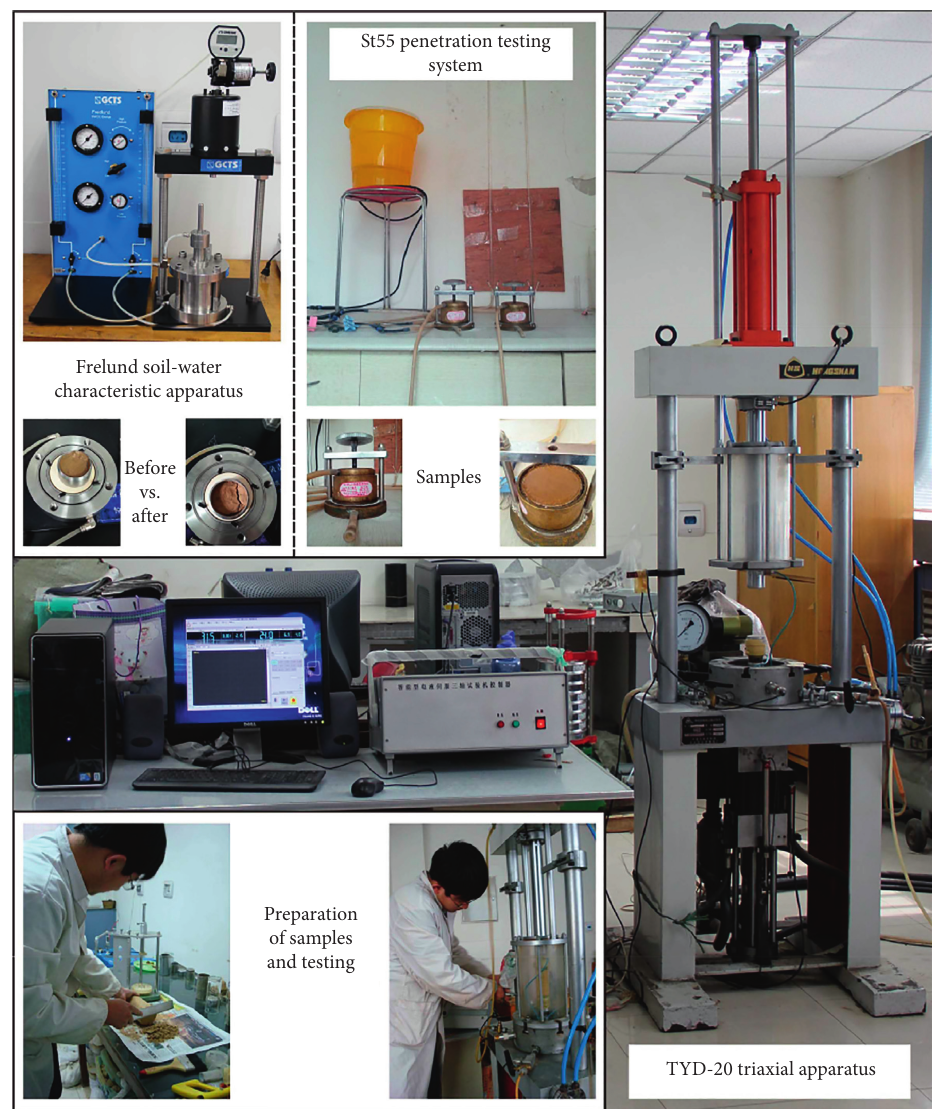
Figure 3: Three kinds of laboratory tests and